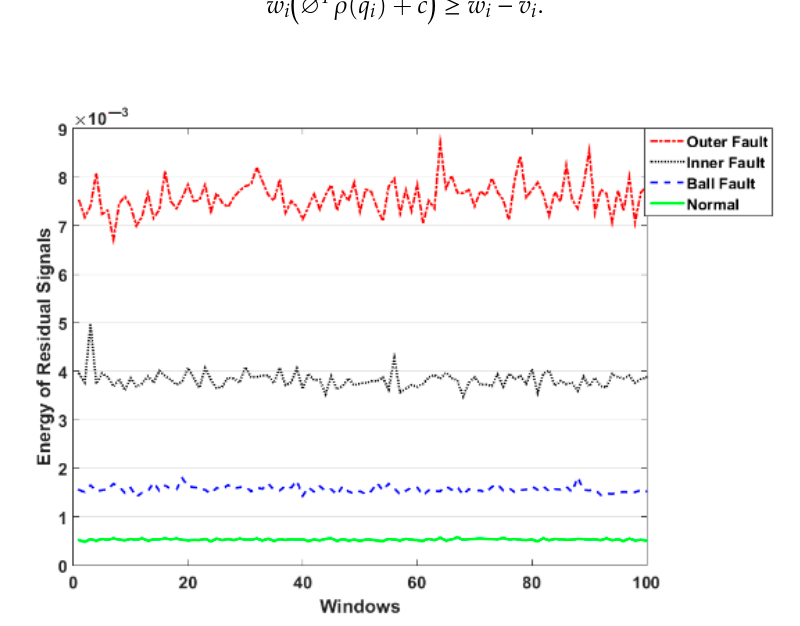
Figure 4. The energy extracted from residual signals of the CWRU dataset using the Adaptive Cascade Observer.